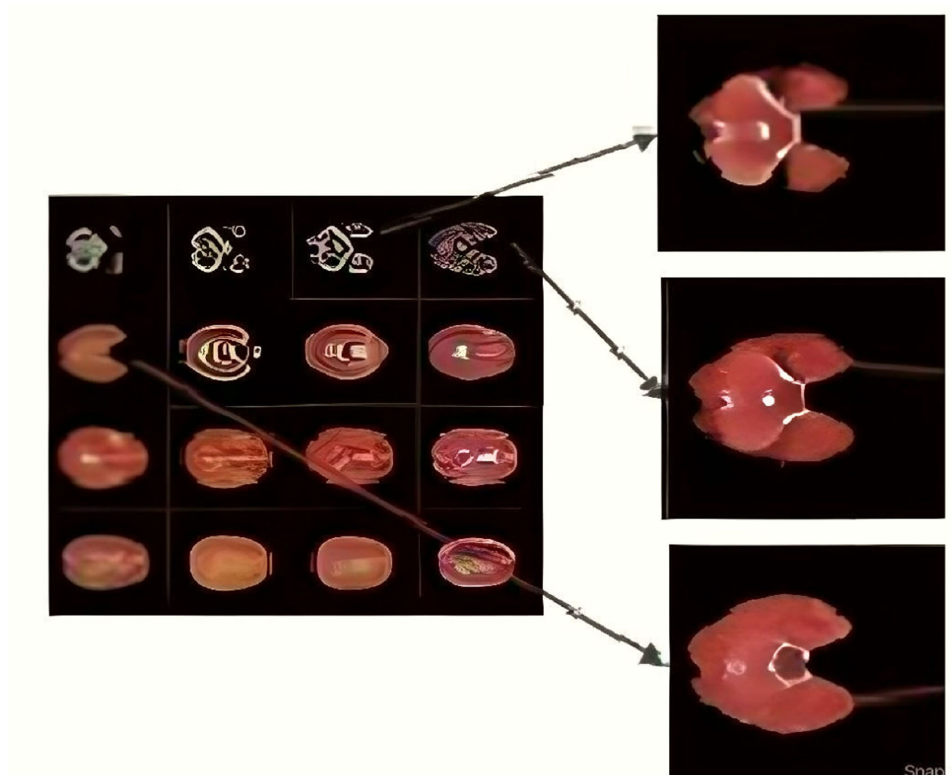
Figure 8. MRI compression using core wavelet families.